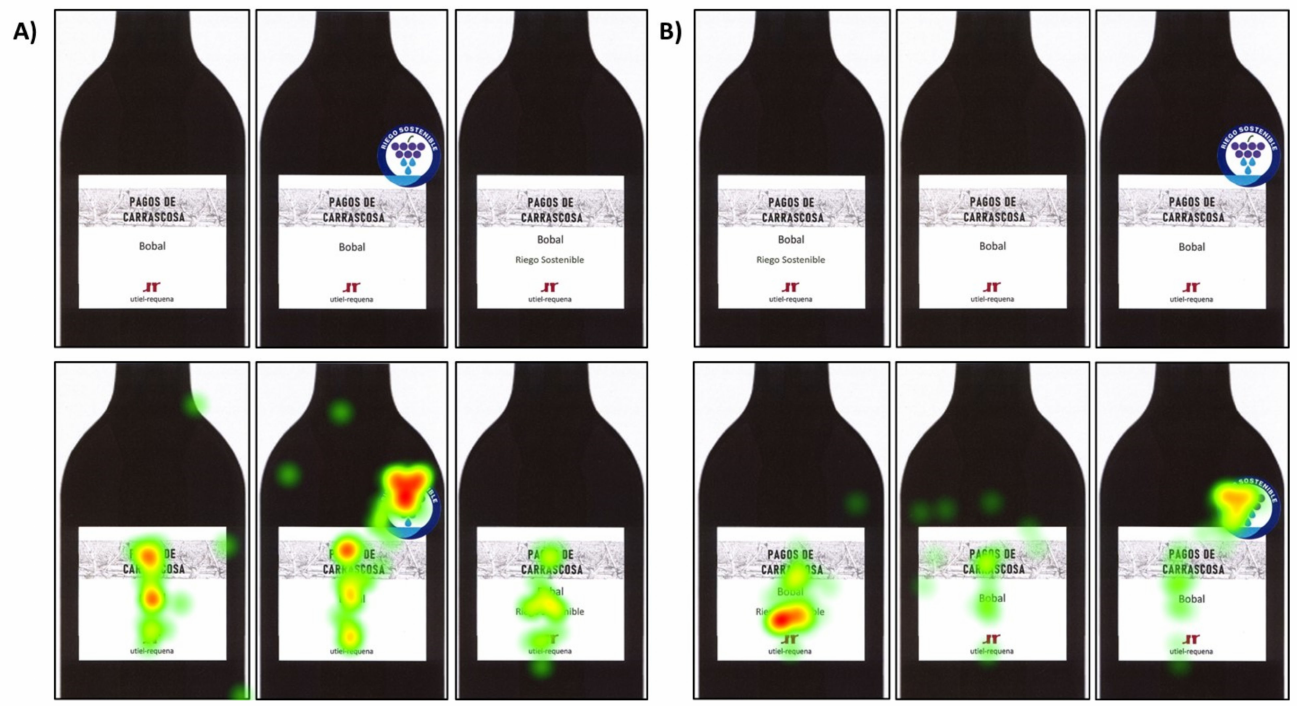
Figure 4. Heatmaps of visual attention (total fixation duration) of a consumer who chose logo-label ( A ) and for another who chose text-label ( B ). Dark red corresponds to long fixation durations and light green to short fixation durations. Both upper images are examples of how wine bottles were displayed on